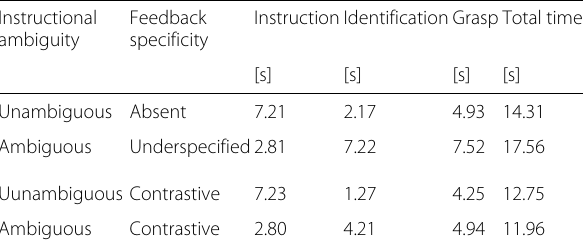
Table 1 Mean durations of the interaction phases in Experiment